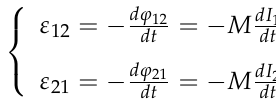
Figure 1. Basic schematic of radio charging.